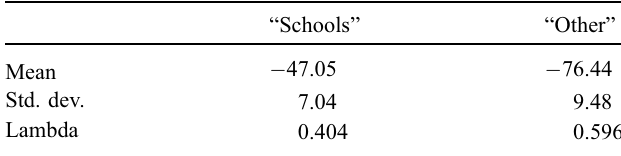
Fig. 3. (a) Histograms of sampled raw S v values from schools (grey bars) and from category “ other ” (empty bars) for seven echograms associated to fi shing hauls with small pelagic fi sh catches. (b) Histogram of pooled S v data regardless of category with the Gaussian PDFs fi tted by the EM algorithm. The vertical black line at the intersection of the curves represents the optimal (cid:1) 59.4dB threshold. (c) Posterior probabilities of assigning a given S v value to each group. The red and green lines in (b) and (c) represent, respectively, the “ other ” and “ schools ” categories. Table 2. Estimated parameters of the probability density functions of Table 3. Complementary posterior probabilities for the categories “ schools ” and “ other ” , and the corresponding S S v values for components “ schools ” and “ other ” , and the fi nal mixing v proportions (lambda).